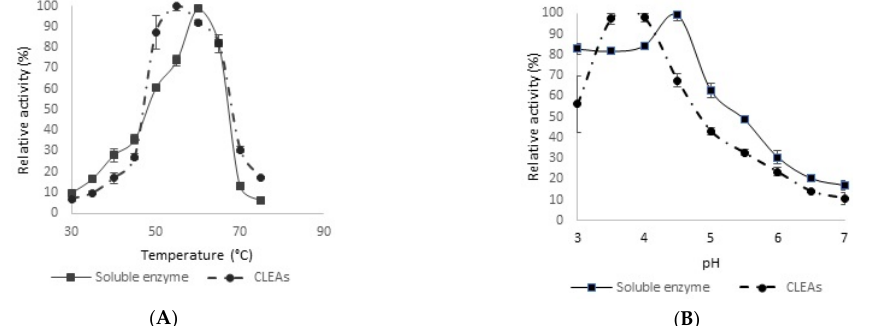
Figure 4. Hydrolytic activity profiles of soluble and immobilized β -glucosidase as a function of optimal temperature ( A ) and pH ( B ) conditions.